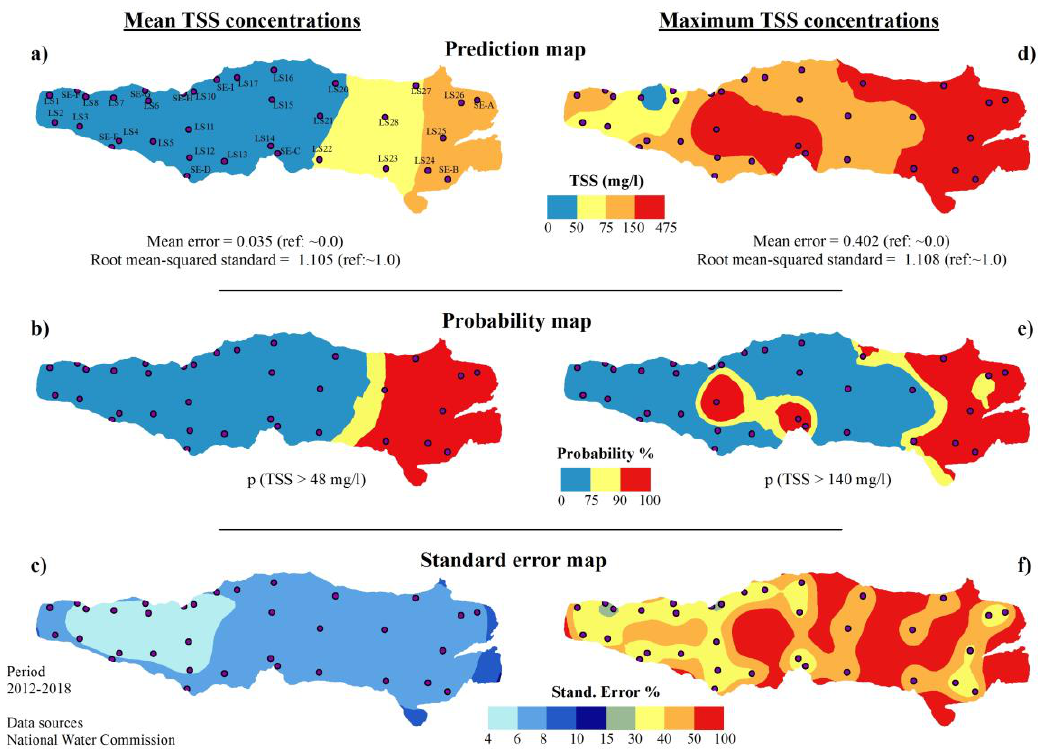
Figure 3. Geostatistical analysis of the total suspended solids (TSS) in Lake Chapala. Concerning to the mean TSS concentrations: ( a ) Prediction map, ( b ) Probability to overcome the average values, and ( c ) Spatial distribution of the standard error. Concerning to the maximum TSS concentrations: ( d ) Prediction map, ( e ) Probability to overcome the average values, and ( f ) Spatial distribution of the standard error.